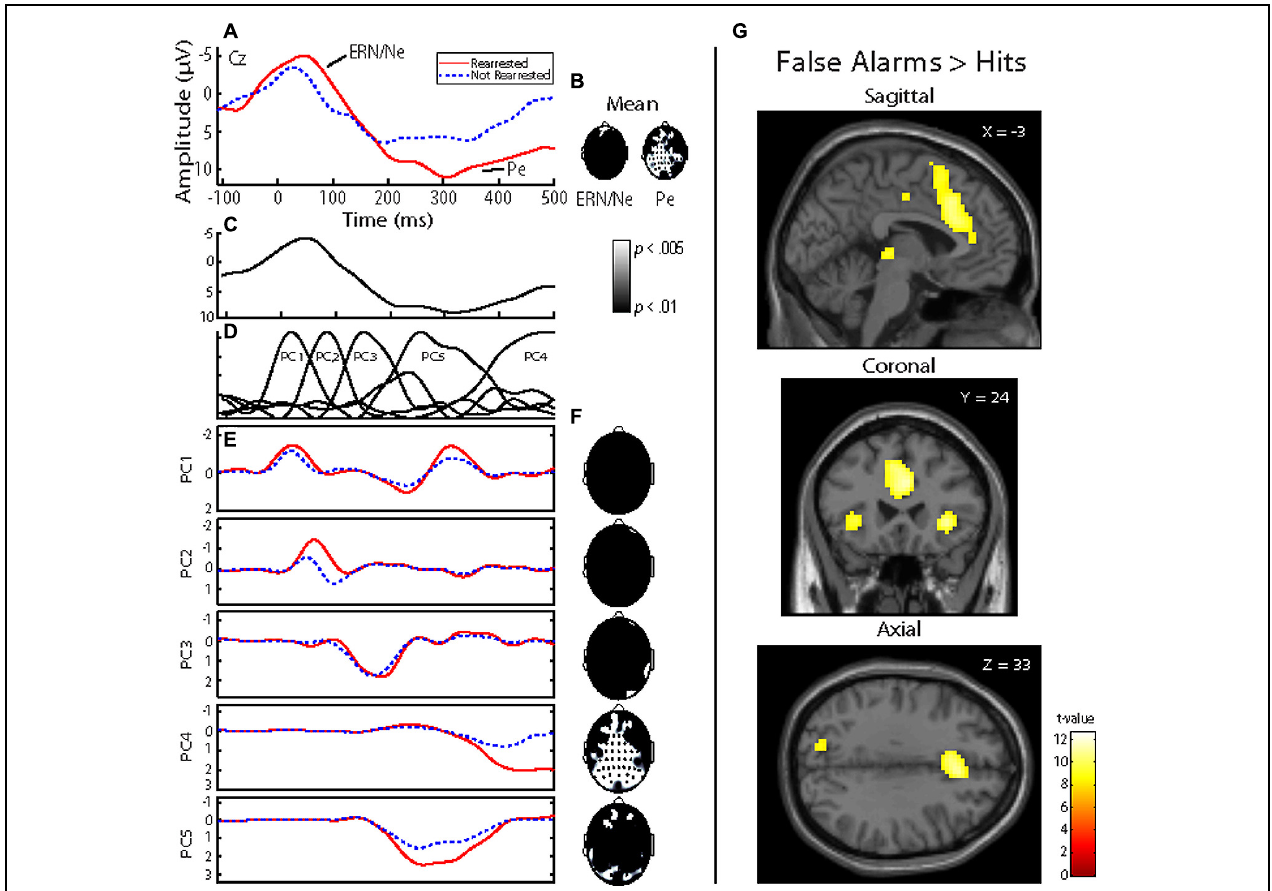
FIGURE 1 | Event-related potential (ERP) and functional magnetic resonance imaging (fMRI) analysis of False Alarms. (A) Representative ERP waveform plotted at Cz for each group. Negative is plotted up. Individuals who were rearrested (solid red line) and not rearrested (dashed blue line) are plotted. ERP components of interest (ERN/Ne and Pe) are identified. (B) Topographical statistical difference (black and white) maps are plotted for each component window highlighting individuals who were rearrested exhibited increased Pe amplitude. Groups did not exhibit different ERN/Ne amplitudes. (C) Grand average waveform plotted at Cz. (D) A five-component principal